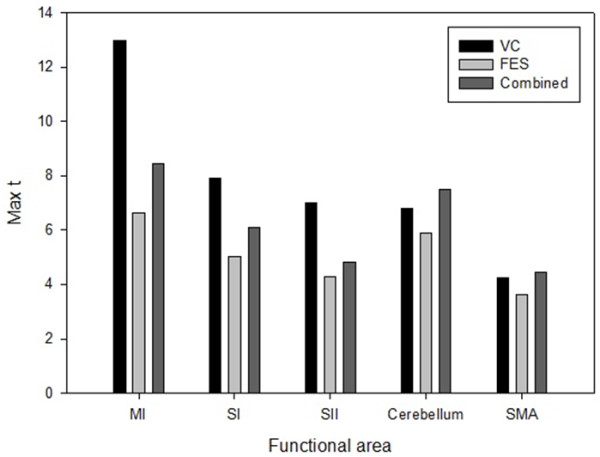
 Comparison of brain activation extents during three stimulation sessions. Abbreviations: Max t, maximum t-score, VC, voluntary contraction, FES, functional electrical stimulation, MI, primary motor cortex, SI, primary somatosensory cortex, SII, secondary somatosensory cortex, SMA, supplementary motor area.